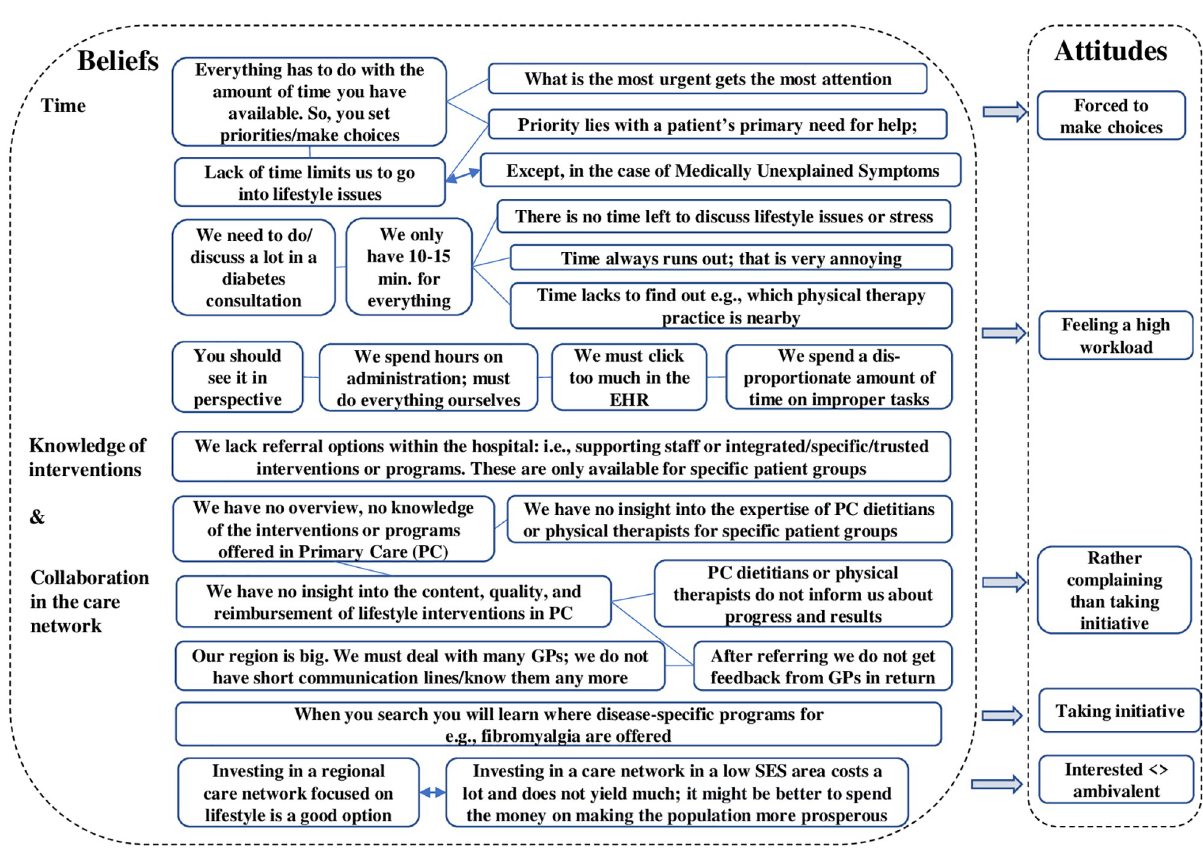
Fig 5. Schematical overview of the beliefs and attitudes about time, the internists’ knowledge of interventions and collaboration in the care network.